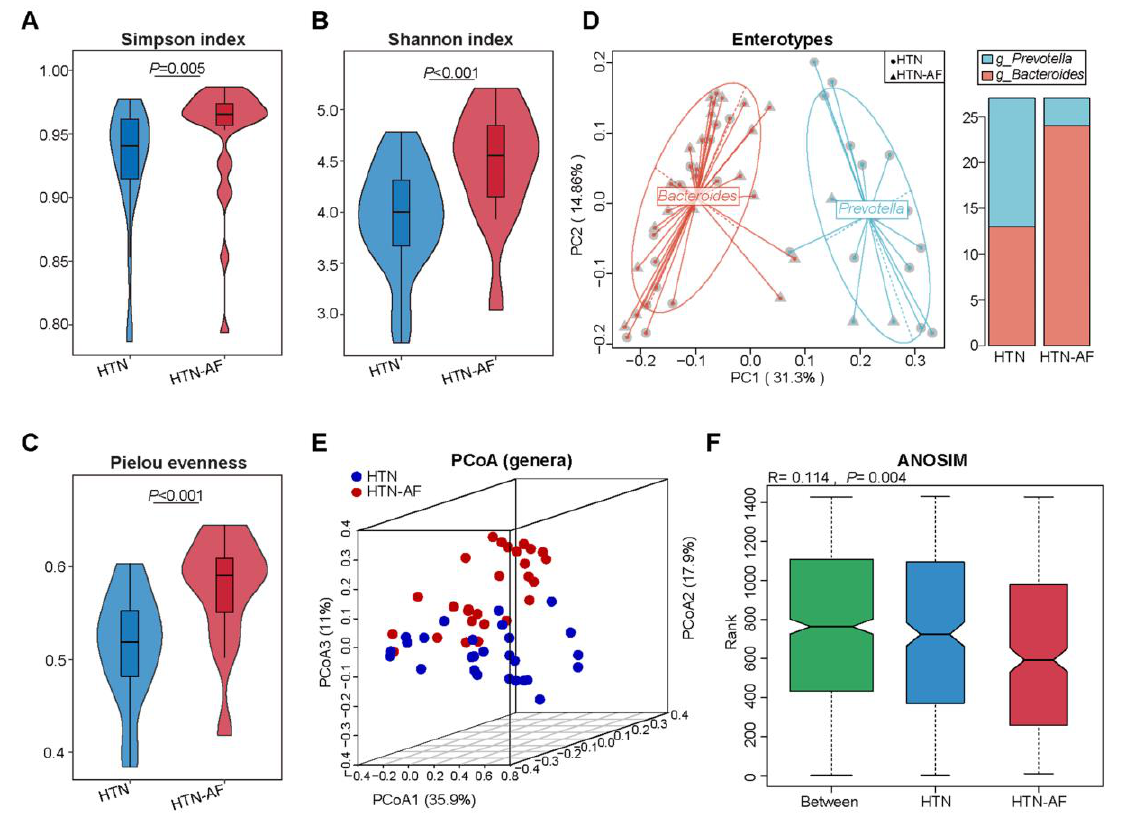
Figure 2. Elevated microbial diversity and altered GM structure in HTN patients with AF. ( A – C ) Differences in alpha-diversity of gut microbiota between HTN and HTN-AF groups, including Simpson index ( A ), Shannon evenness ( B ), and Pielou index ( C ). Wilcoxon rank sum test. ( D ) Left: 54 samples were clustered into two enterotypes dominated by Bacteroides (red) and Prevotella (blue), respectively, using principal coordinate analysis (PCoA) of Jensen – Shannon divergence values at the genus level. Right: the percentage of HTN and HTN-AF samples distributed in two enterotypes. ( E ) PCoA plots based on genus showed the variant gut microbial structures in the two groups. ( F ) ANOSIM analysis of GM between the two groups.